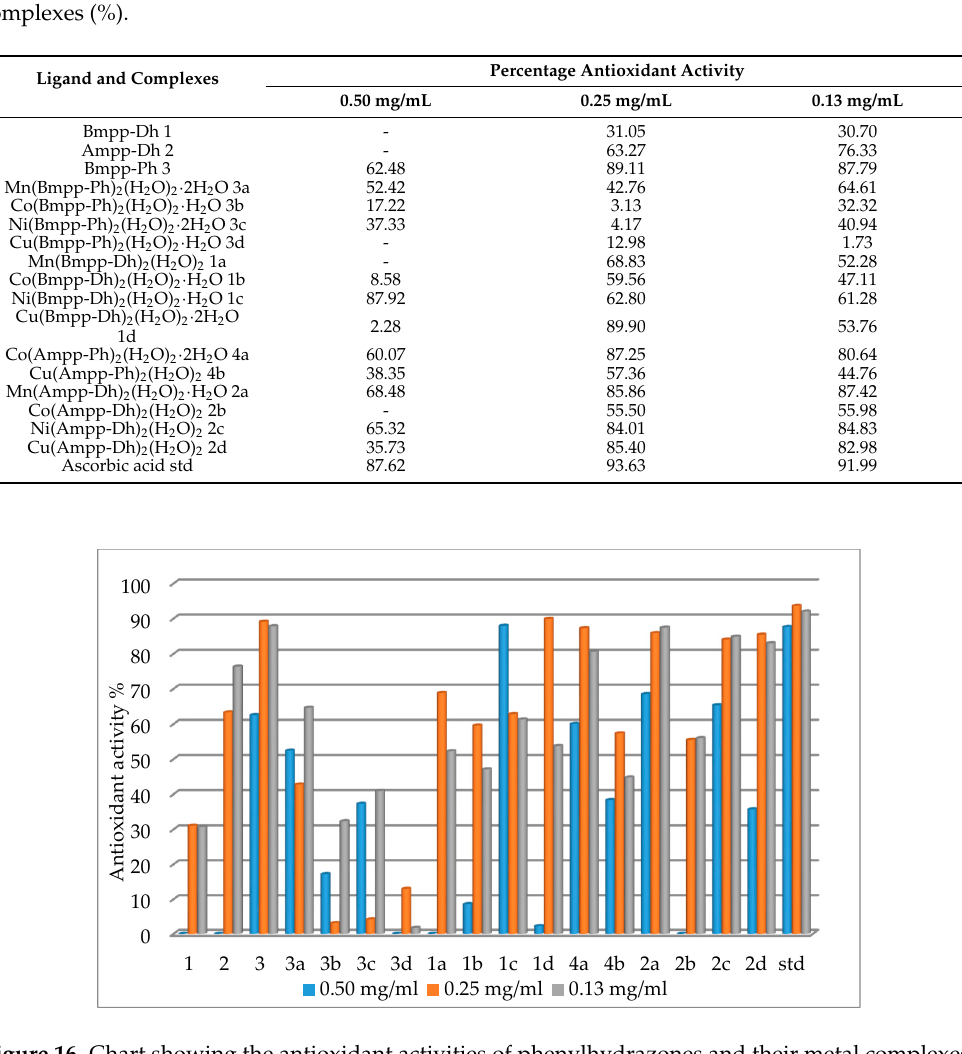
Figure 16. Chart showing the antioxidant activities of phenylhydrazones and their metal complexes.